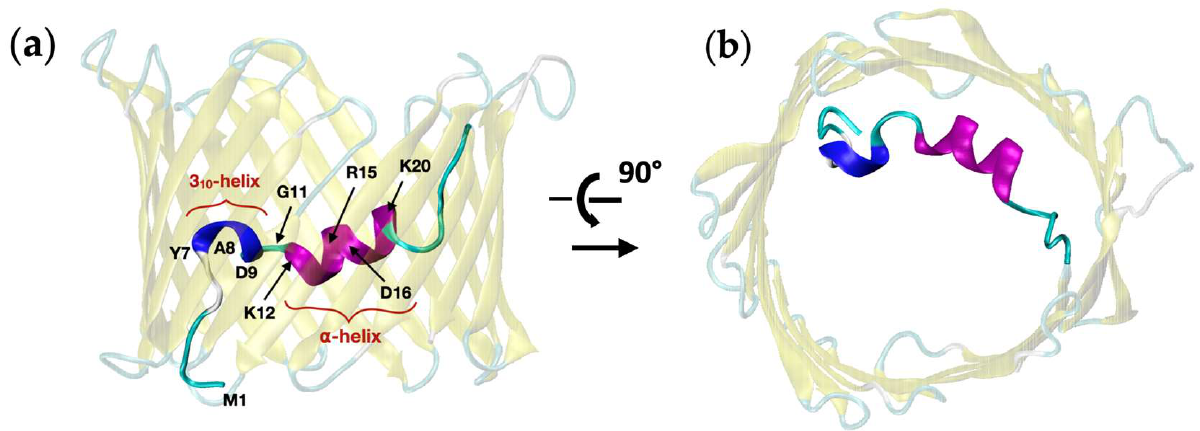
Figure 1. Structure of mVDAC1 solved by crystallography (PDB ID: 3EMN, adapted from Ref. [18], 2.3 Å-resolution) attributed to the open state of the channel. Key residues and major structural components of the N-terminus (residues M1 to G25), including the 3 10 - and alpha helices, are shown. ( a ) Side view (MOM), ( b ) top view.